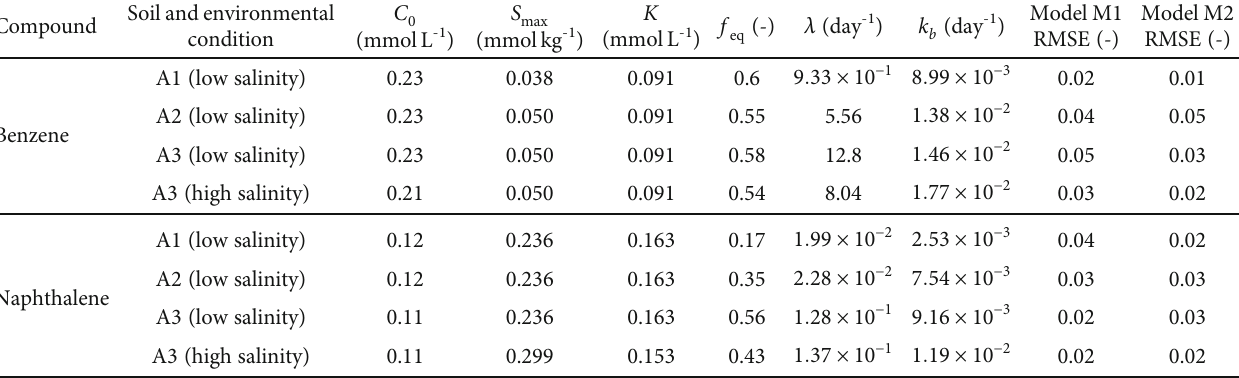
Table 5: Initial concentrations and parameters of the two-site sorption and biodegradation kinetic models M1 and M2. Soil and Compound